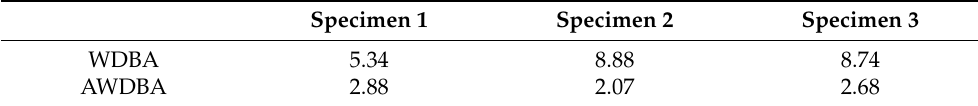
Table 2. Mean value of AVG_Dis for all augmentation